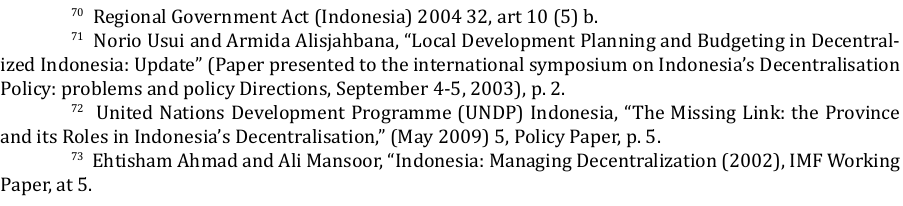
Figure 1. The administrative arrangement in